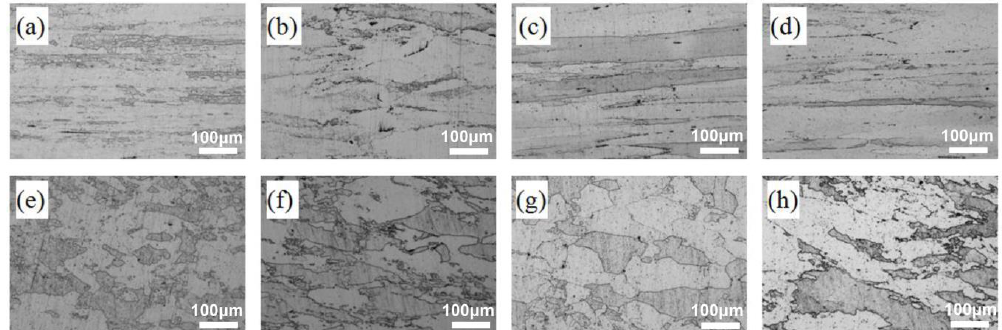
Figure 2. Optical micrographs of the aged alloys: ( a , e ) 0.98 wt.%Cu; ( b , f ) 1.45 wt.%Cu; ( c , g ) 1.69 wt.%Cu; ( d , h ) 2.02 wt.%Cu; L-T: ( a – d ); S-T: ( e – h ).